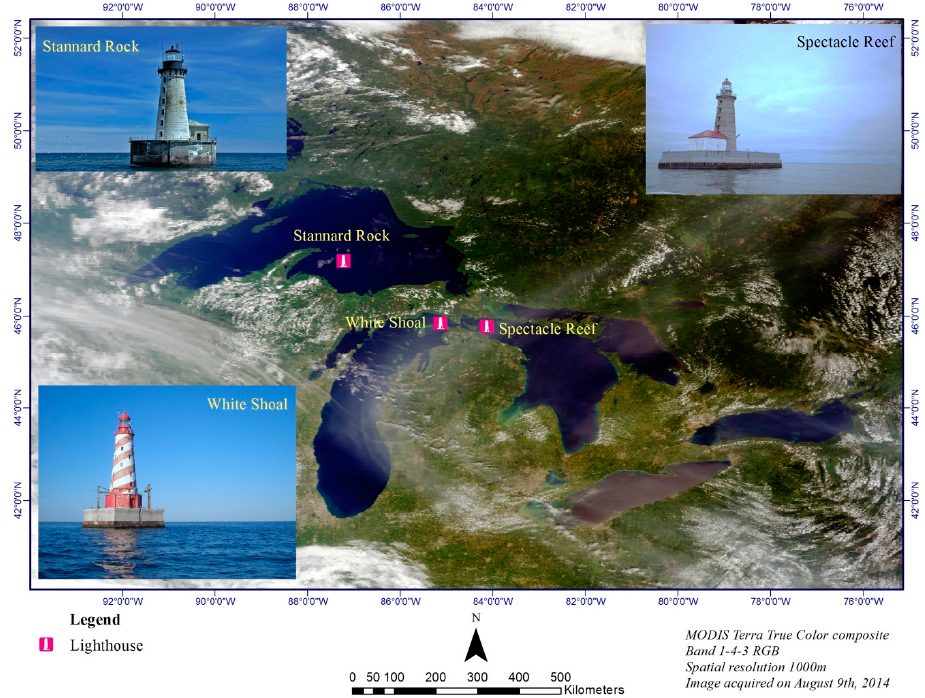
Figure 1. Locations of over-lake meteorological stations at SR (Lake Superior), SP (Lake Huron) and WS (Lake Michigan).